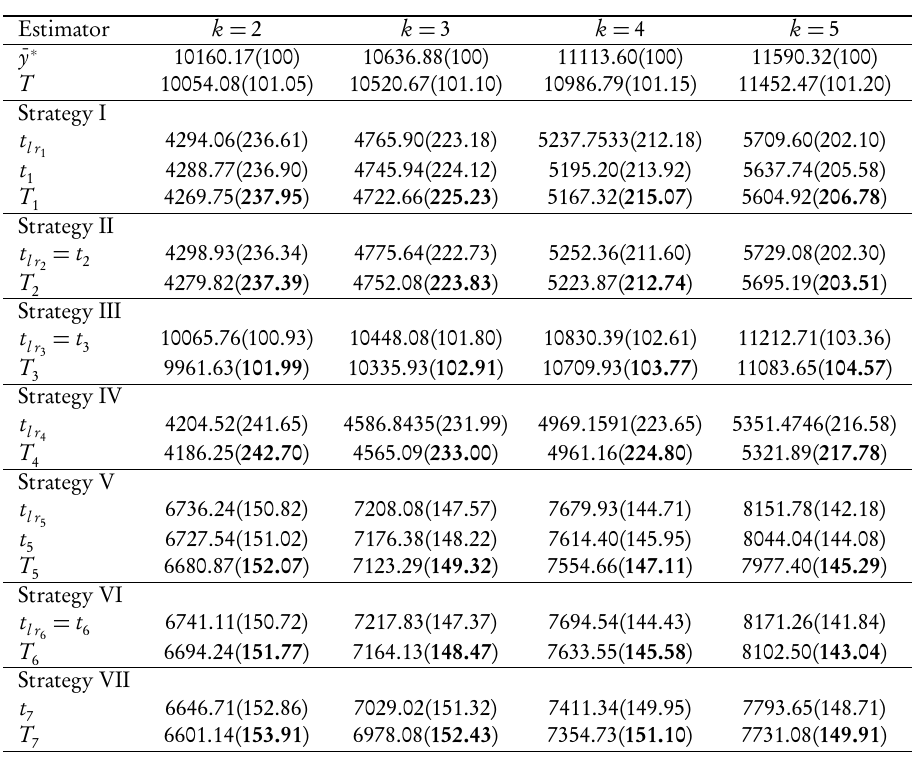
MSE and PRE of the existing estimators and proposed estimators for the first